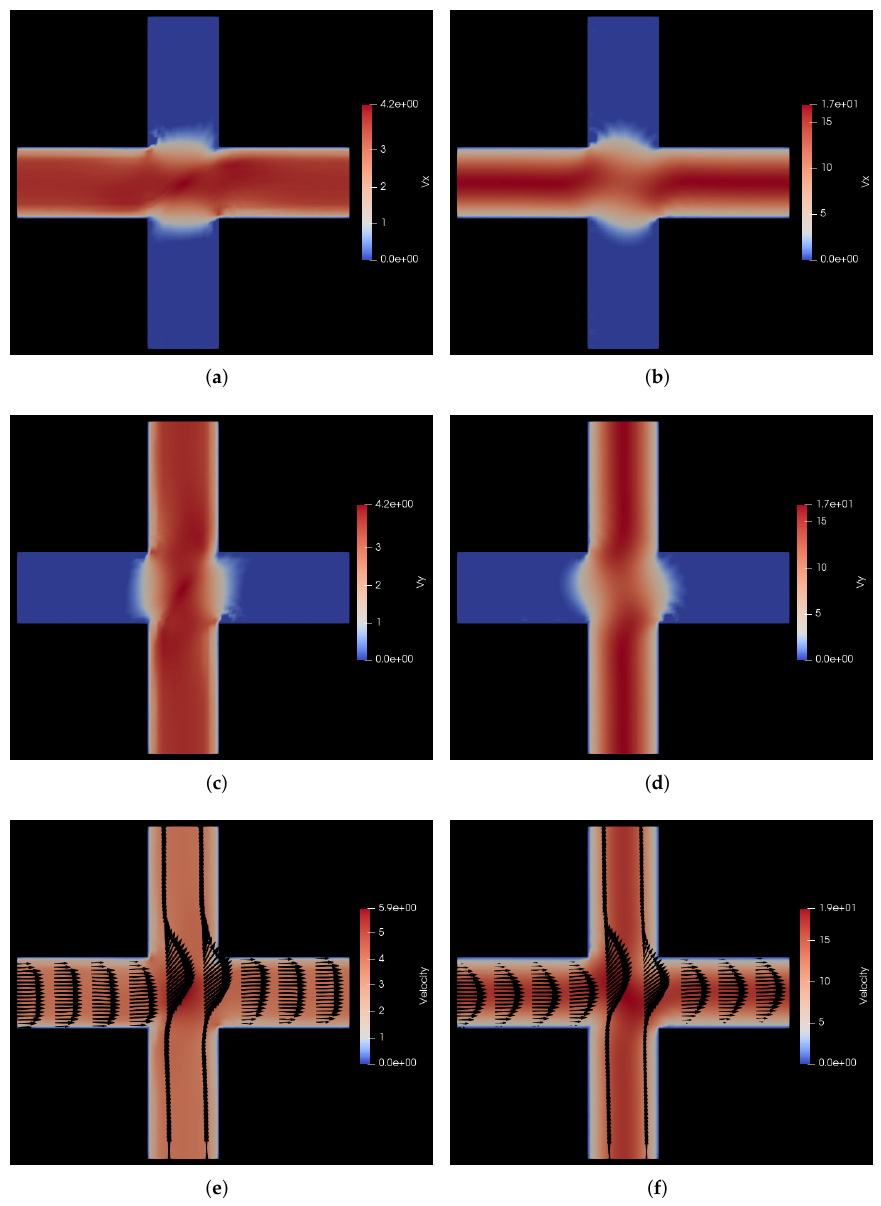
Figure 9. Comparison of velocity profiles for flow of polymer solution with the flow of solvent through a cuboidal porous medium with pressure applied along the positive x - y diagonal. ( a ) v x for flow of polymer solution. Here, v x varies from 0 to 4.2 σ /s, i.e., 0 to 21 µ m/s; ( b ) v x for flow of solvent. Here, v x varies from 0 to 17 σ /s, i.e., 0 to 85 µ m/s; ( c ) v y for flow of polymer solution. Here, v y varies from 0 to 4.2 σ /s, i.e., 0 to 21 µ m/s; ( d ) v y for flow of solvent. Here, v y varies from 0 to 17 σ /s, i.e., 0 to 85 µ m/s; ( e ) v for flow of polymer solution. Here, v varies from 0 to 5.9 σ /s, i.e., 0 to 29.5 µ m/s; ( f ) v for flow of solvent Here, v varies from 0 to 19 σ /s, i.e., 0 to 95 µ